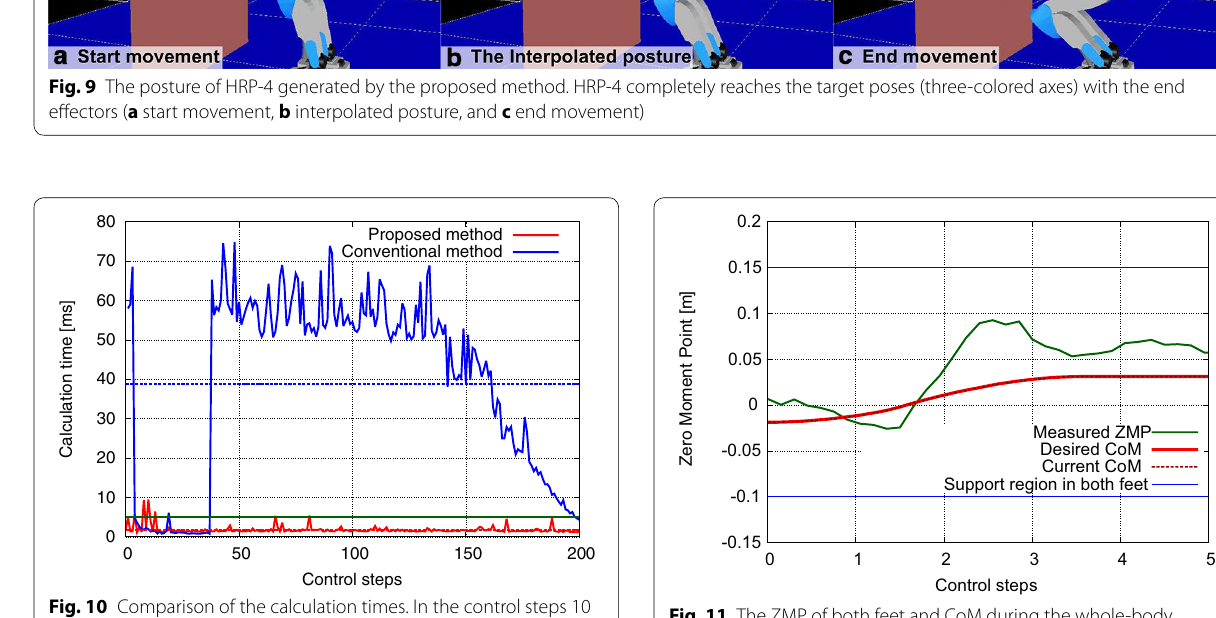
Fig. 11 The ZMP of both feet and CoM during the whole-body movement. The support region between the two blue lines repre- sents the area from the toe to the